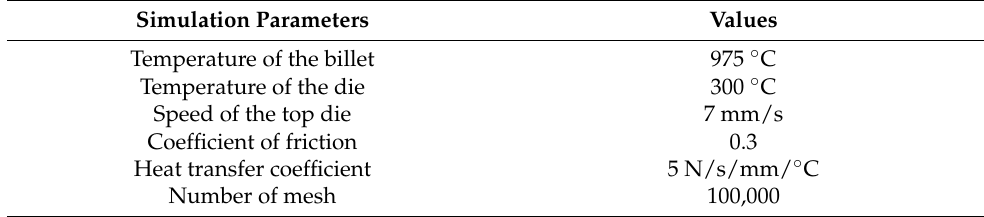
Figure 4. FE model of forming: [*] represents the direction of movement. Table 3. Parameters of finite element